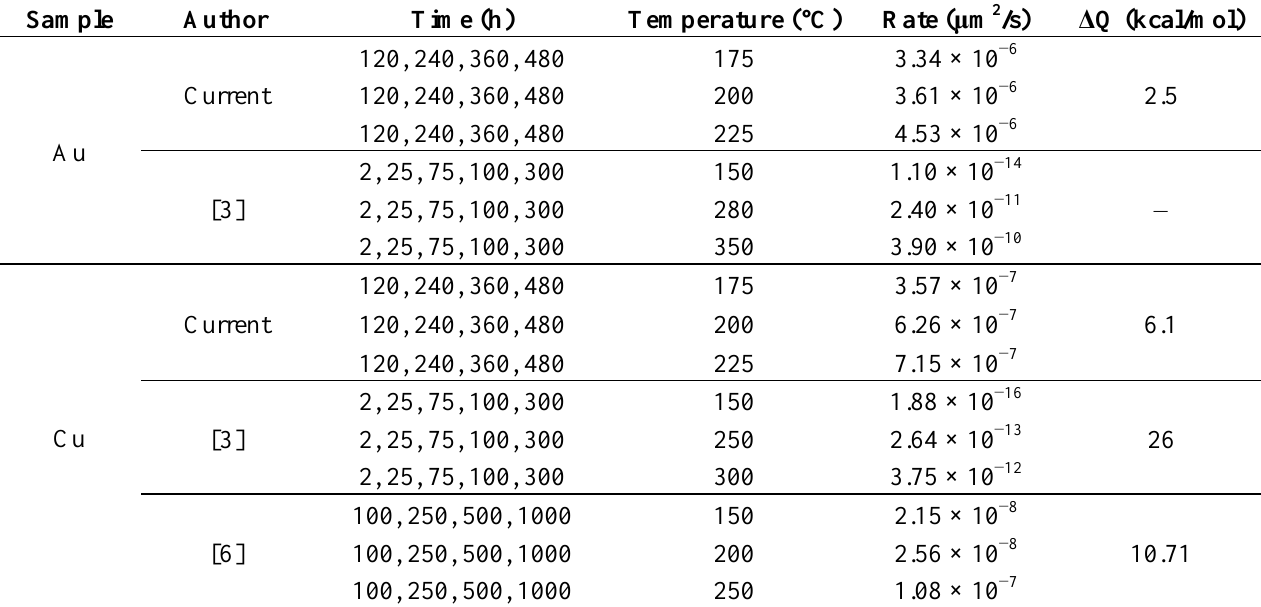
Table 4. Comparison of intermetallic growth rates and activation energies for Au/Al and Cu/Al.